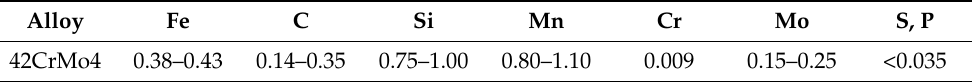
Figure 3. Microstructure of 42CrMo4 disc; approximately 90% bainite, 5% ferrite, and 5% martensite (etching: ethanol with 3% HNO 3 ). Table 3. Chemical composition of the disc material by element in